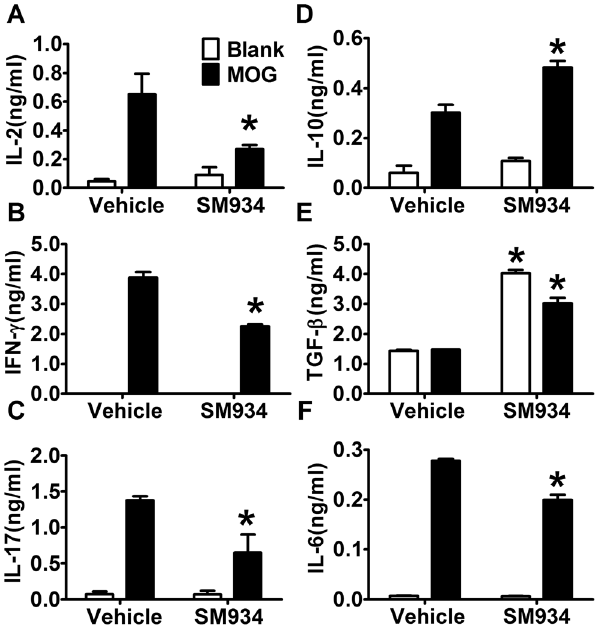
Figure 2. SM934 treatment suppressed MOG-specific pro- inflammatory cytokines and enhanced MOG-specific anti- inflammatory cytokines production in splenocytes from EAE mice. Splenocytes from immunized mice treated with vehicle or SM934 (10 mice per group) were isolated at the peak of disease (day 18 p.i.), re- stimulated with MOG 35–55 (10 m g/ml) for 72 hours. Culture supernatants were collected and indicated cytokine levels were measured by ELISA. Results were expressed as mean 6 SEM. *, p , 0.05 compared with vehicle control. Three independent experiments were performed with similar